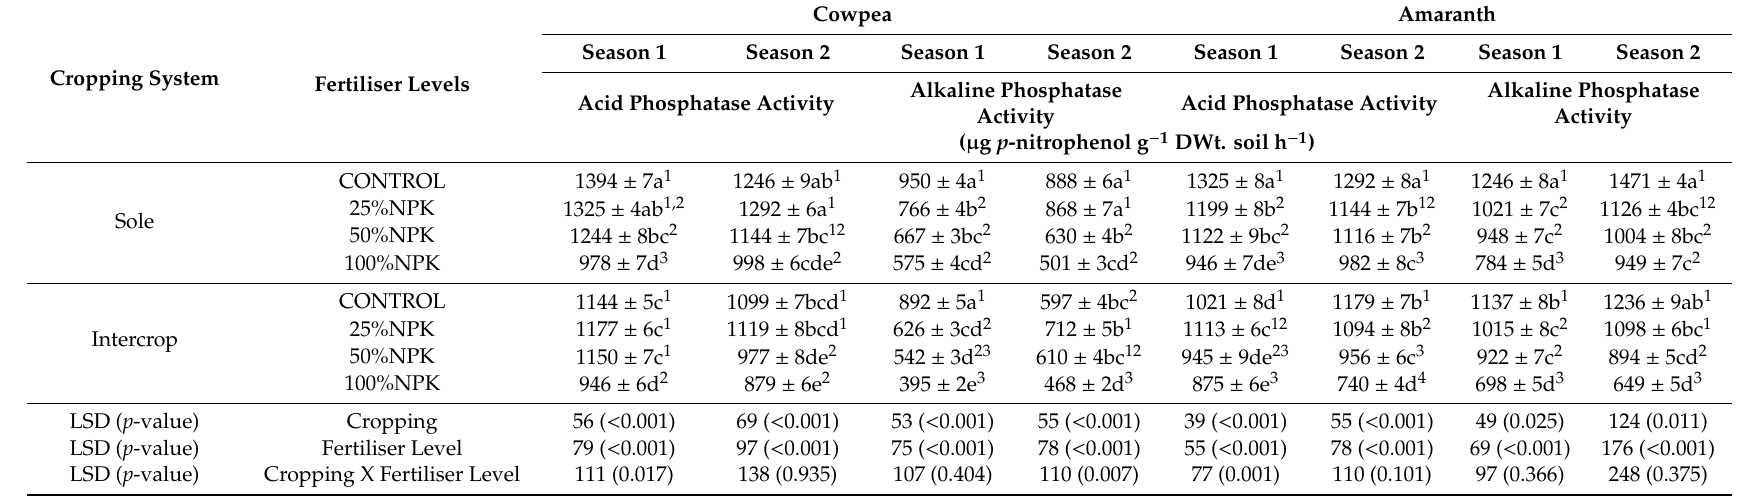
Table 2. Soil acid and alkaline phosphatase in cowpea and amaranth that have been fertilised with four levels of NPK in 2014 / 15 (season 1) and 2015 / 16 (season 2) seasons